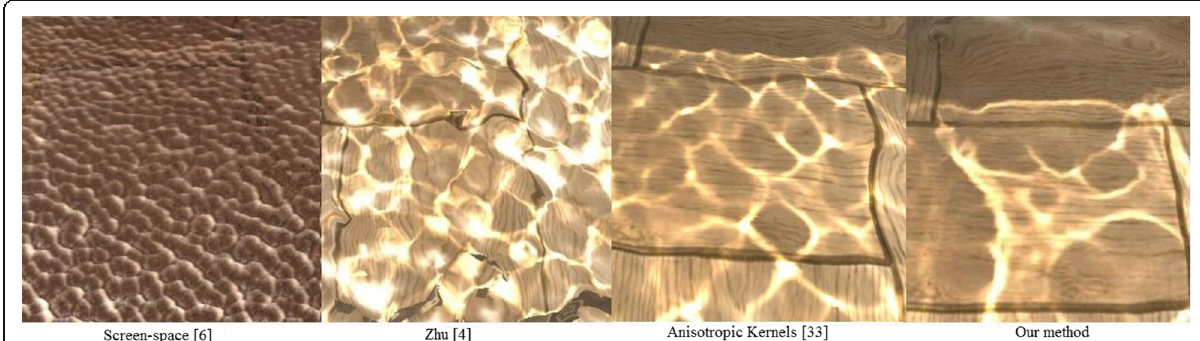
Fig. 11 Comparison of different surface reconstruction approaches